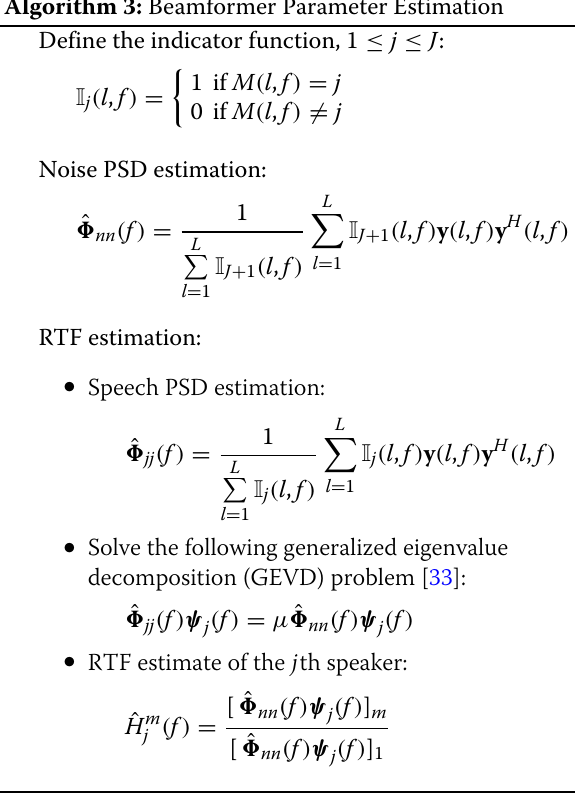
Algorithm 3: Beamformer Parameter